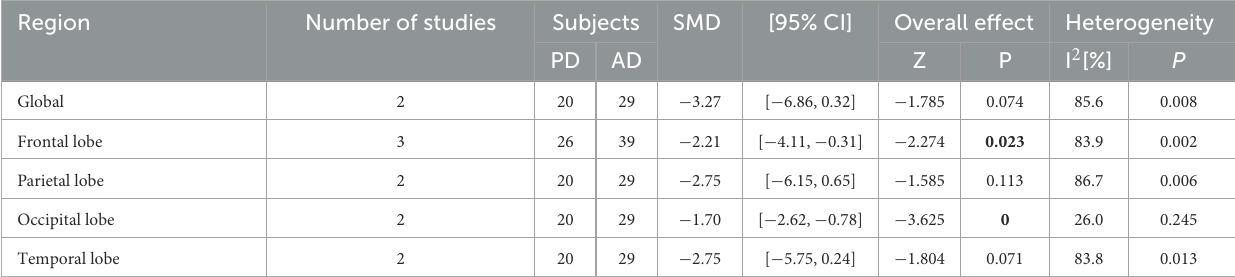
TABLE 8 Random effects meta-analyses results between PD and AD subjects. Region Number of studies